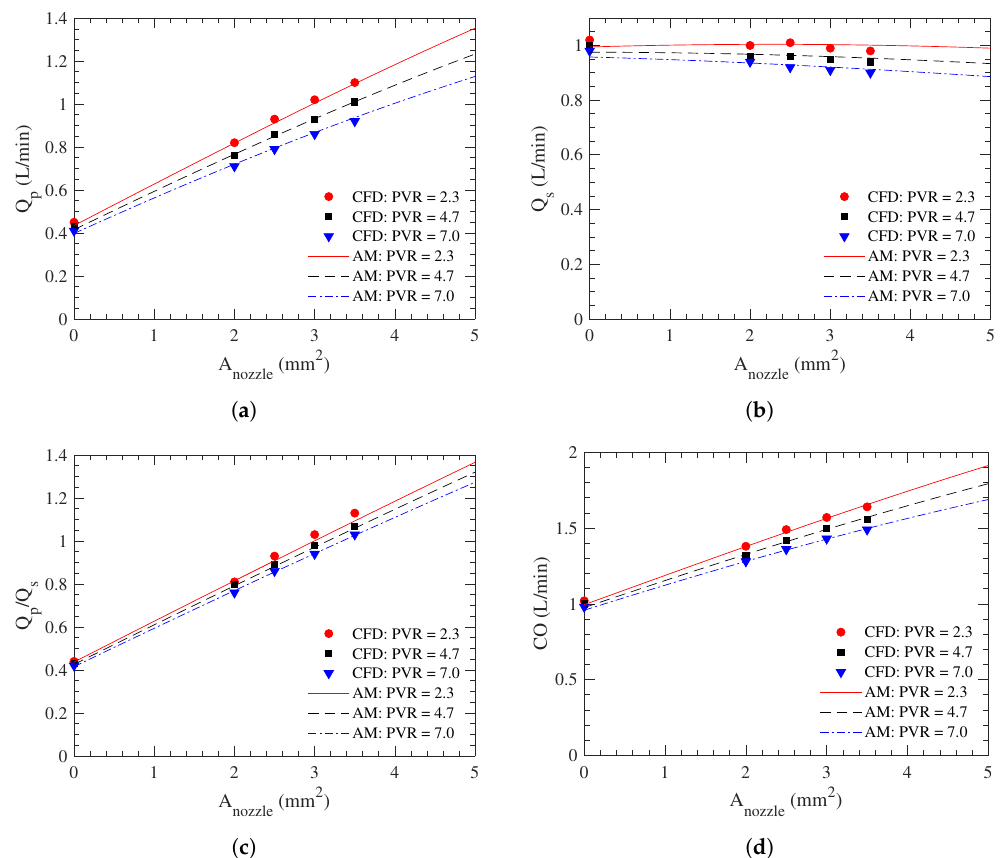
Figure 8. ( a ) The pulmonary average flow rate, Q p ; ( b ) the average systemic flow rate, Q s ; ( c ) the pulmonary-to-systemic flow ratio, Q p / Q s ; and ( d ) the average cardiac output, CO , as a function of the nozzle area, A nozzle , at different PVR values. Lines correspond to the algebraic model (AM) and symbols to the